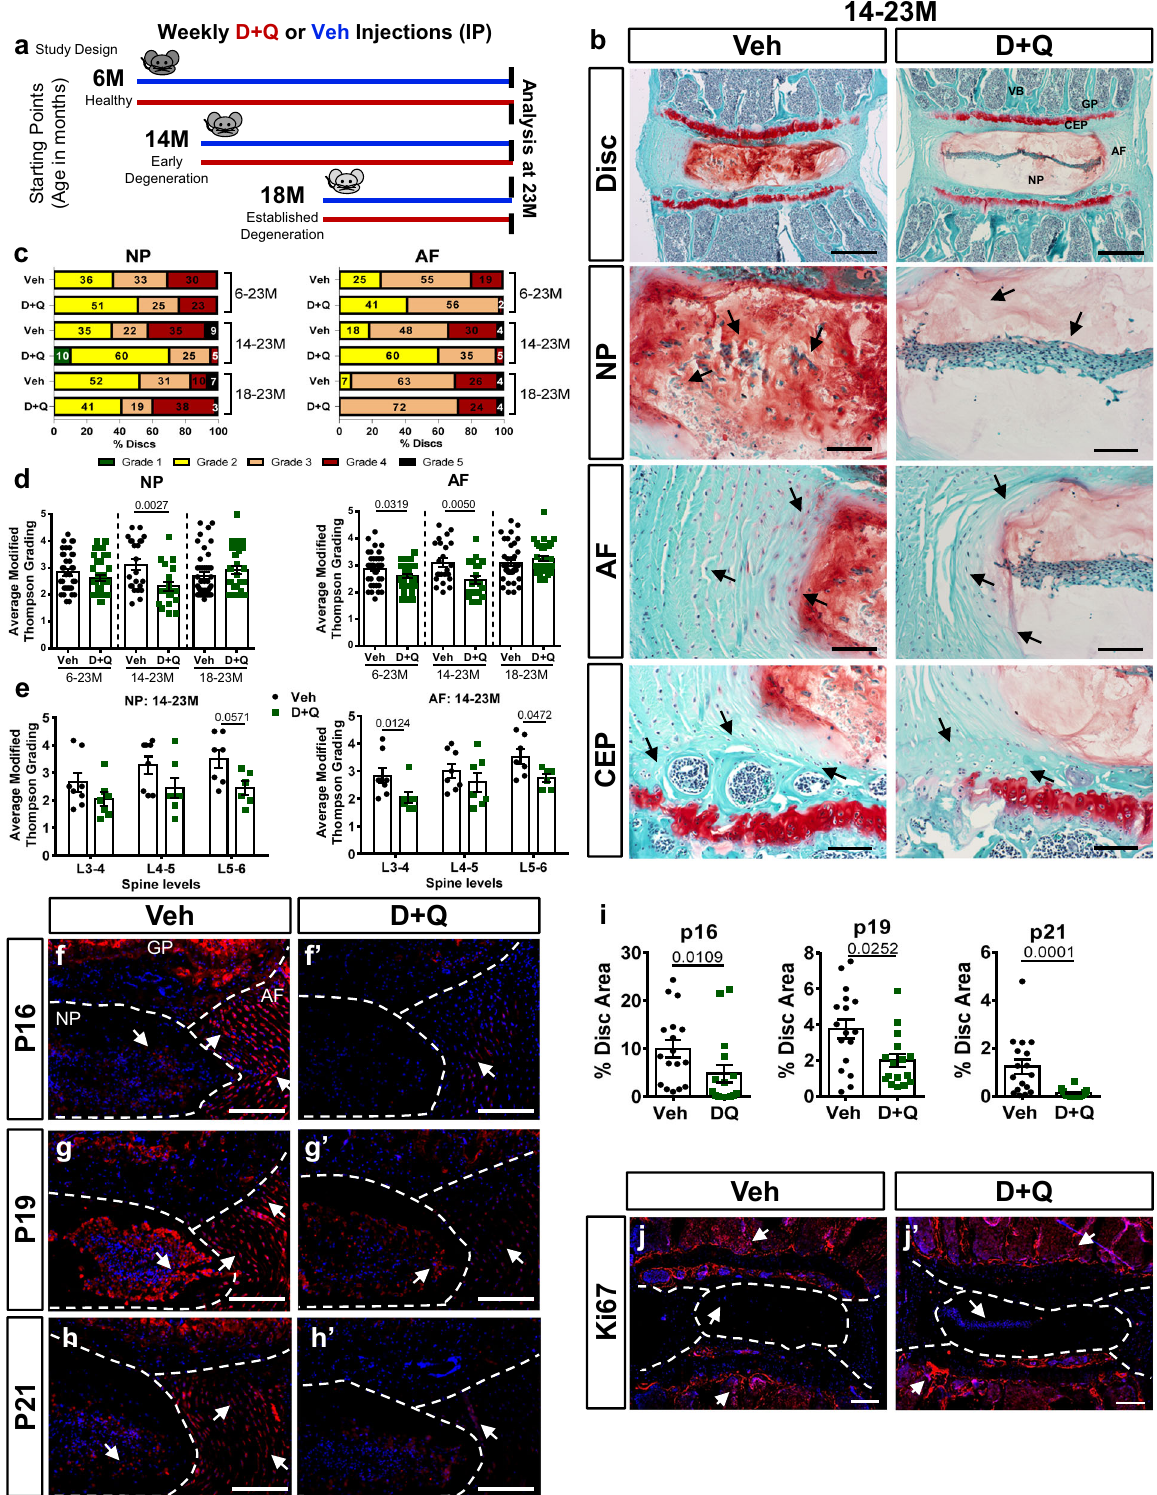
(Fig. 1f – g ’ , i) 12,13,31 – 33 . Similarly, levels of p21, a potent cell cycle inhibitor and key downstream mediator of senescence, was also decreased in the D + Q group (Fig. 1h – i) 34 . Moreover, while there were no changes in levels of cell cycle inhibitor RB, levels of pRB were lower in D + Q-treated disc (Supplementary Fig. 2a – d). The decrease in senescence burden by D + Q in disc was